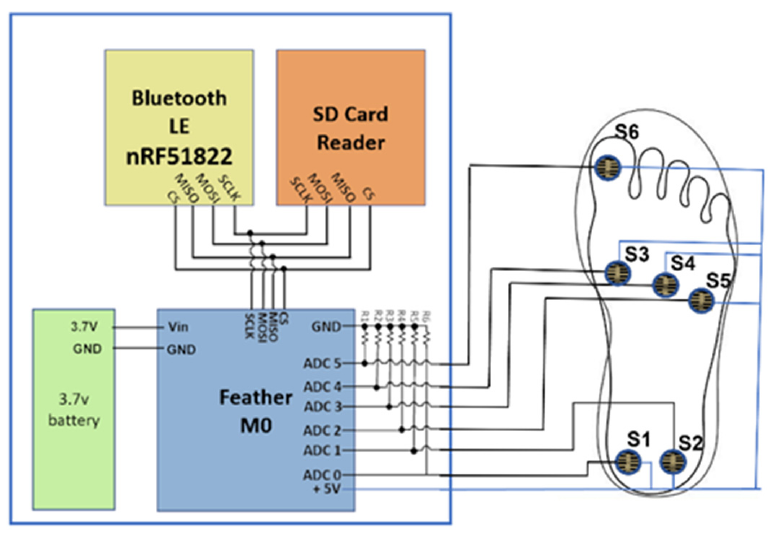
Figure 1. Circuit schematic of the proposed footwear sensor system attached to the right foot.